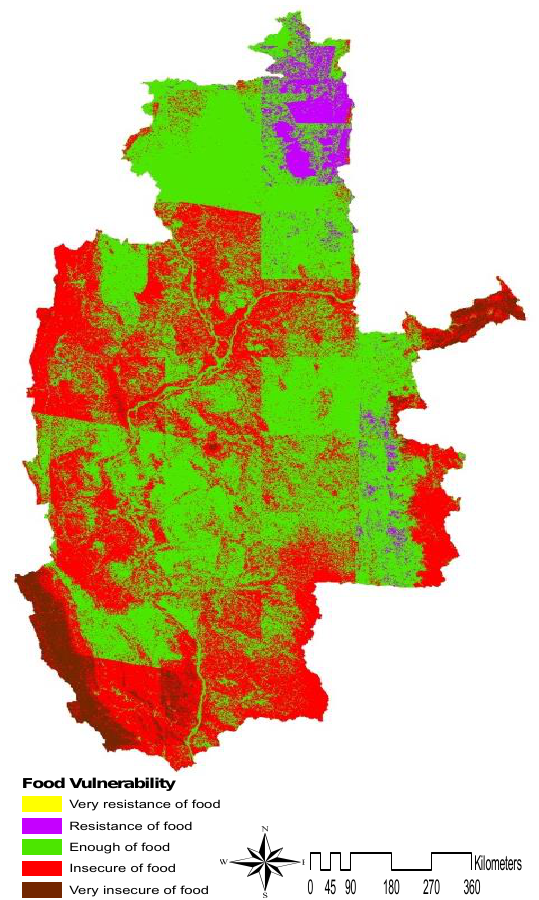
Figure 4. Food vulnerability map of central dry zone area of